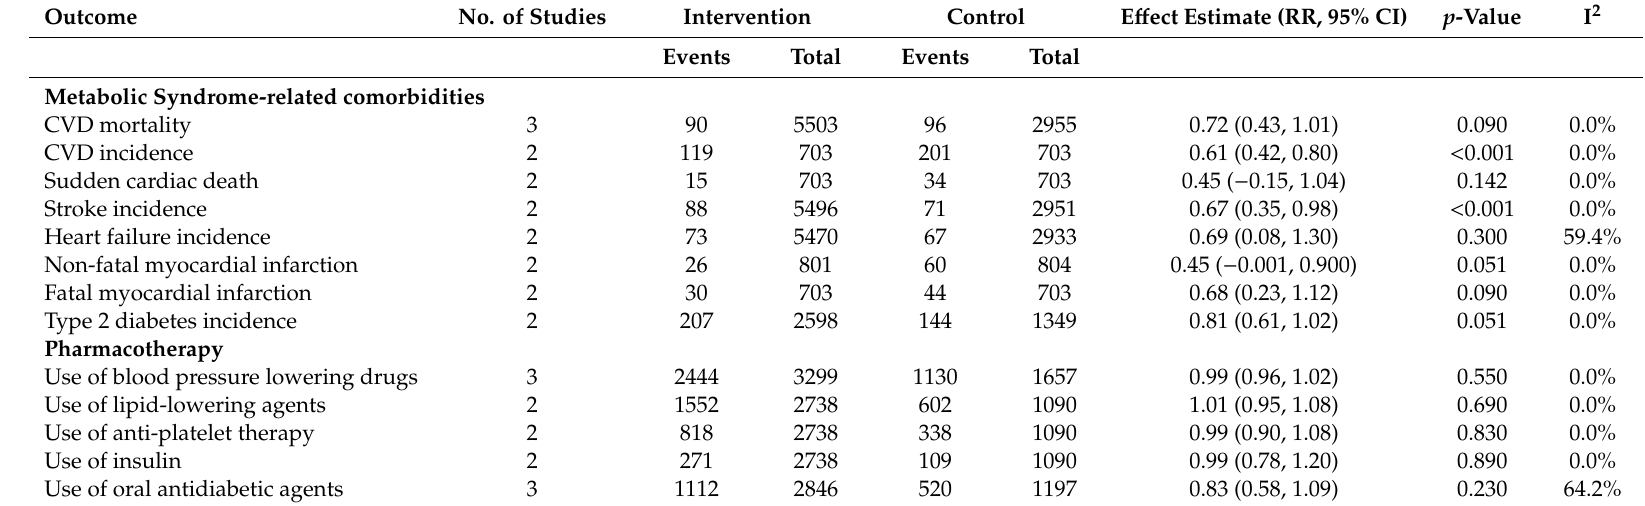
Table 3. E ff ect of the Mediterranean diet on metabolic syndrome-related comorbidities and pharmacologic treatment for metabolic syndrome components and related comorbidities